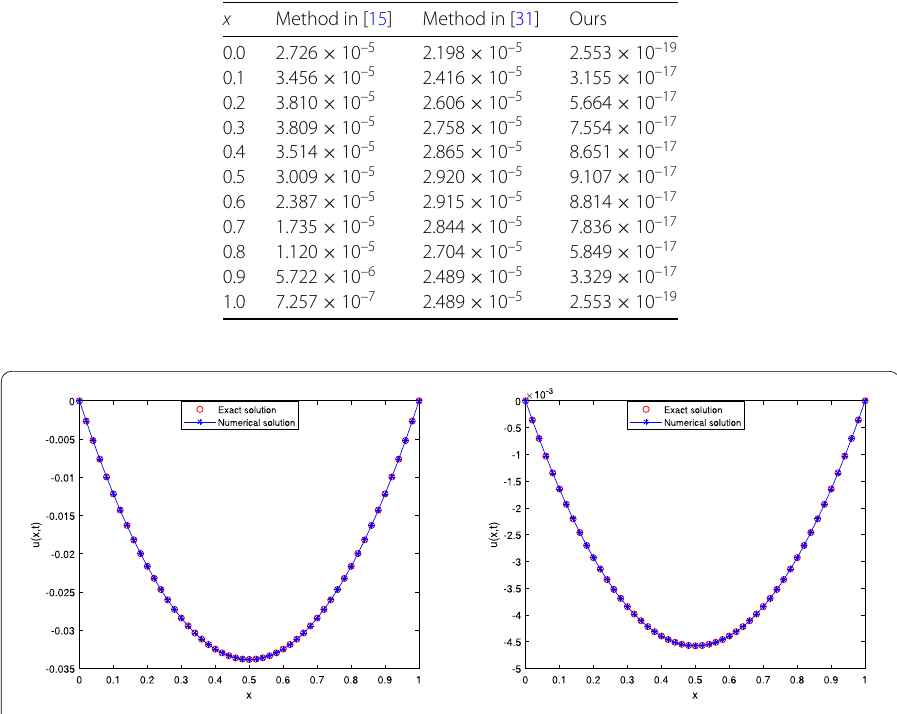
Figure 1 Approximate and analytical solutions of Example 6.1 for n = 3 with final times T = 1 (left), T = 2 (right), and φ ( h ) = 0.5(exp(2 h ) – 1)